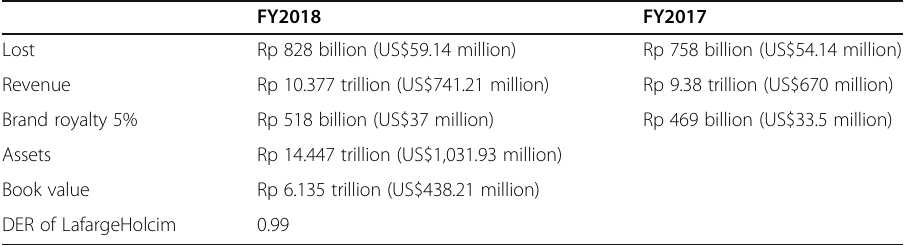
Table 1 Financial evaluation of